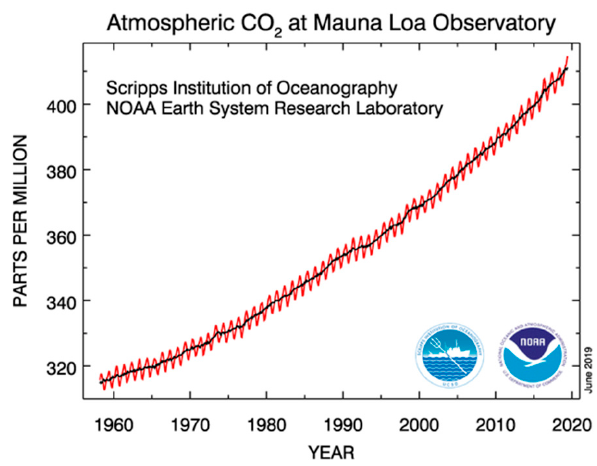
Figure 1. Trends in the atmospheric CO 2 concentration (ppm) [2].